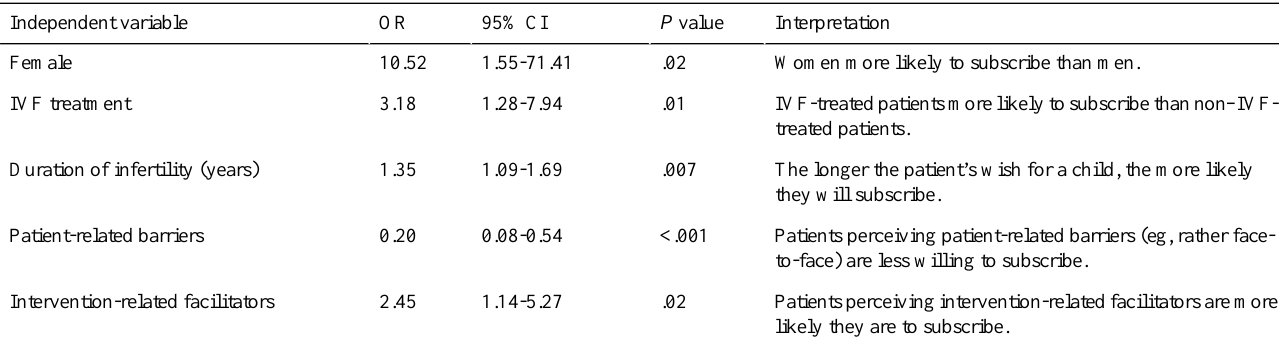
Table 5. Multivariate relationship of background characteristics and sum scores of barriers and facilitators to subscribe to the online health community.